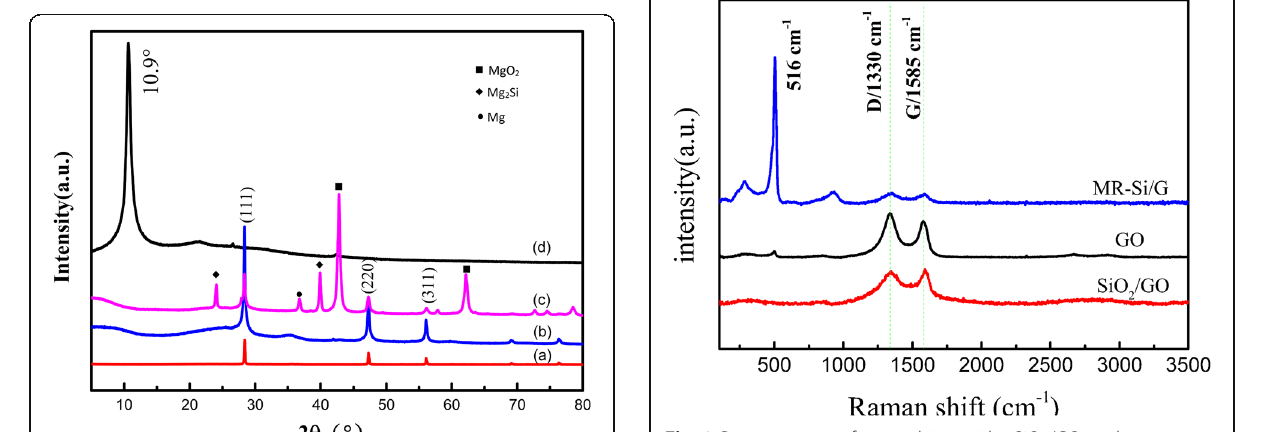
Fig. 3 Raman spectra for graphite oxide, SiO 2 /GO and MR-Si/G composite